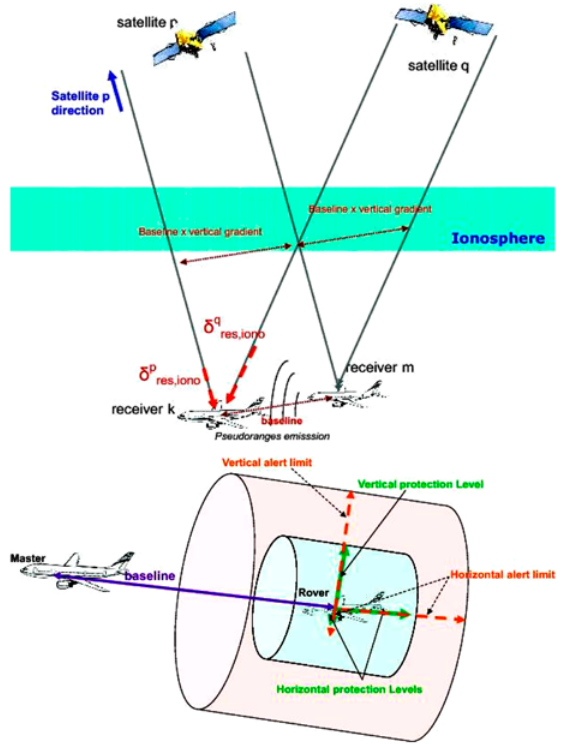
Fig. 3. Protection levels in relative navigation. We can see